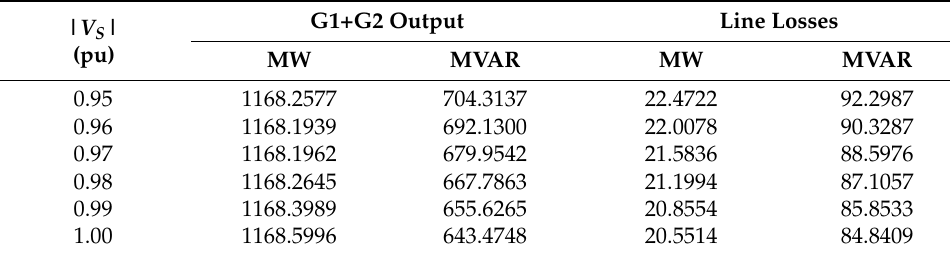
Table 9. G1+G2 output and line loss ( V w = 8 m/s).